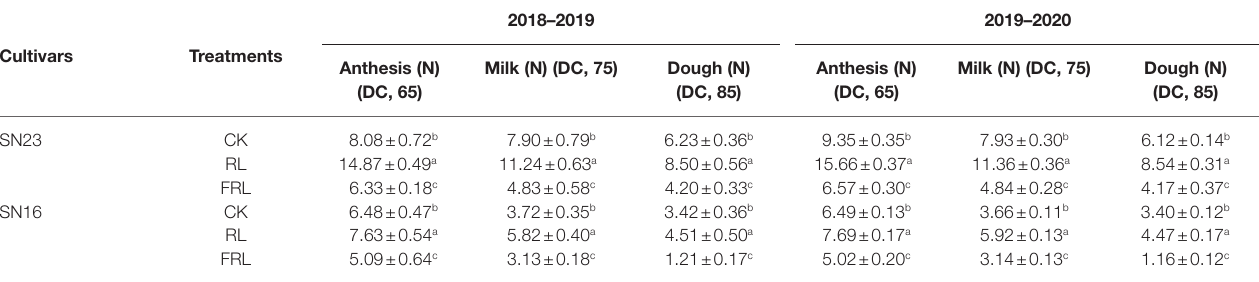
SN16 and SN23 represent the lodging-sensitive cultivar Shangnong16 and the lodging-resistant cultivar Shangnong23. CK represents the normal light, RL represents the red light, and FRL represents far-red light. Data are the means ± SD of 10 replicates. Values followed by different letters are significantly different at p < 0.05 (n = 10).